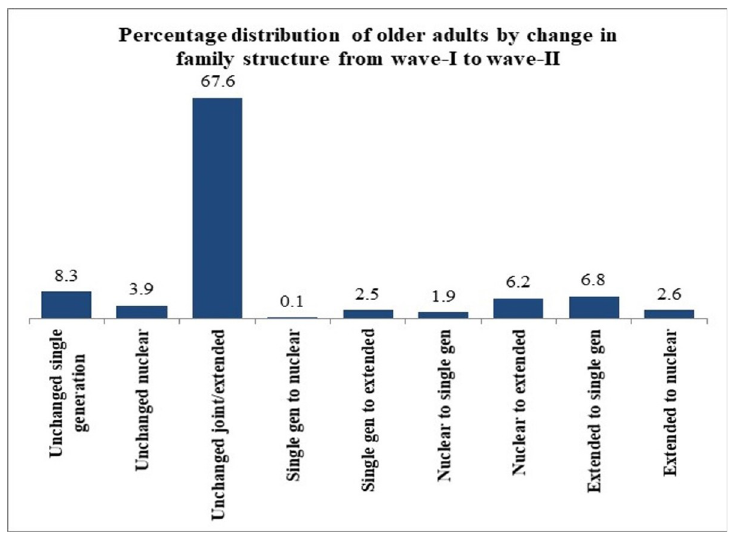
Fig 1. Distribution of older adults by change in family structure from wave-I to wave-II.